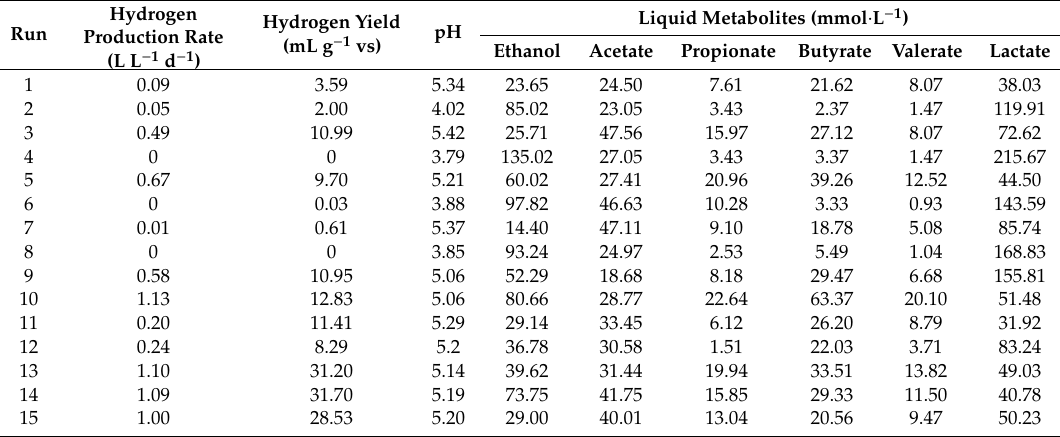
Table 3. Experimental design matrix and